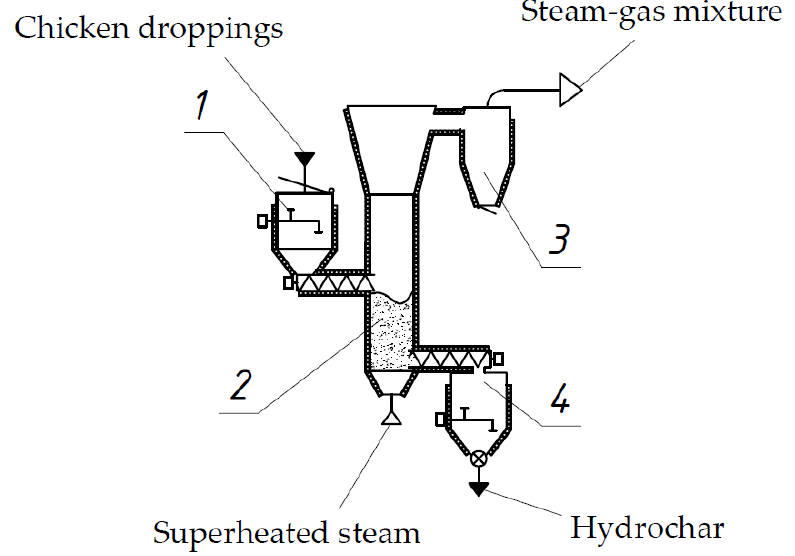
Figure 1. Diagram of the vapothermal carbonization apparatus of biowaste in a fluidized bed in a superheated steam environment: ( 1 ) feedstock bunker for biomass; ( 2 ) reactor; ( 3 ) cyclone; ( 4 ) product bunker for hydrochar recovery.